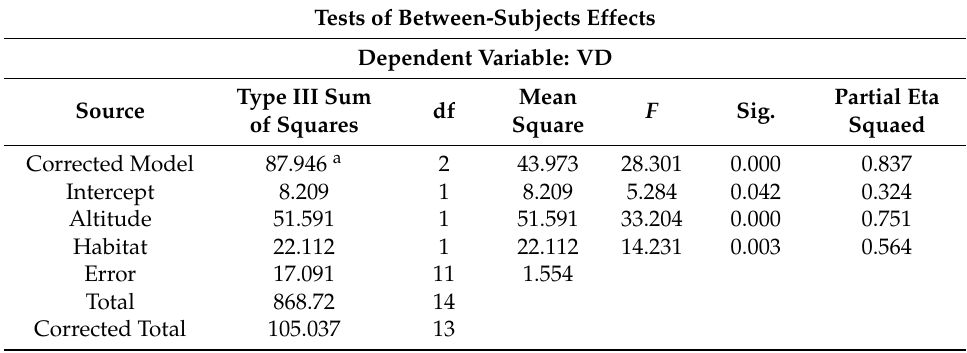
Table A2. The result of ANCOVA between vein density (VD) and altitude in hillside and valley habitats.